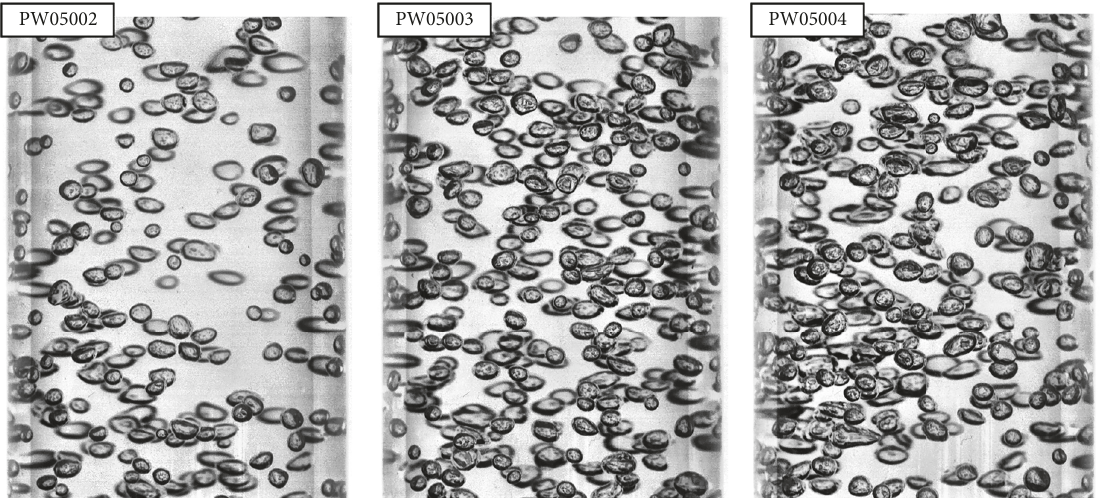
Figure 3: Images obtained for PW05002, PW05003, and PW05004.